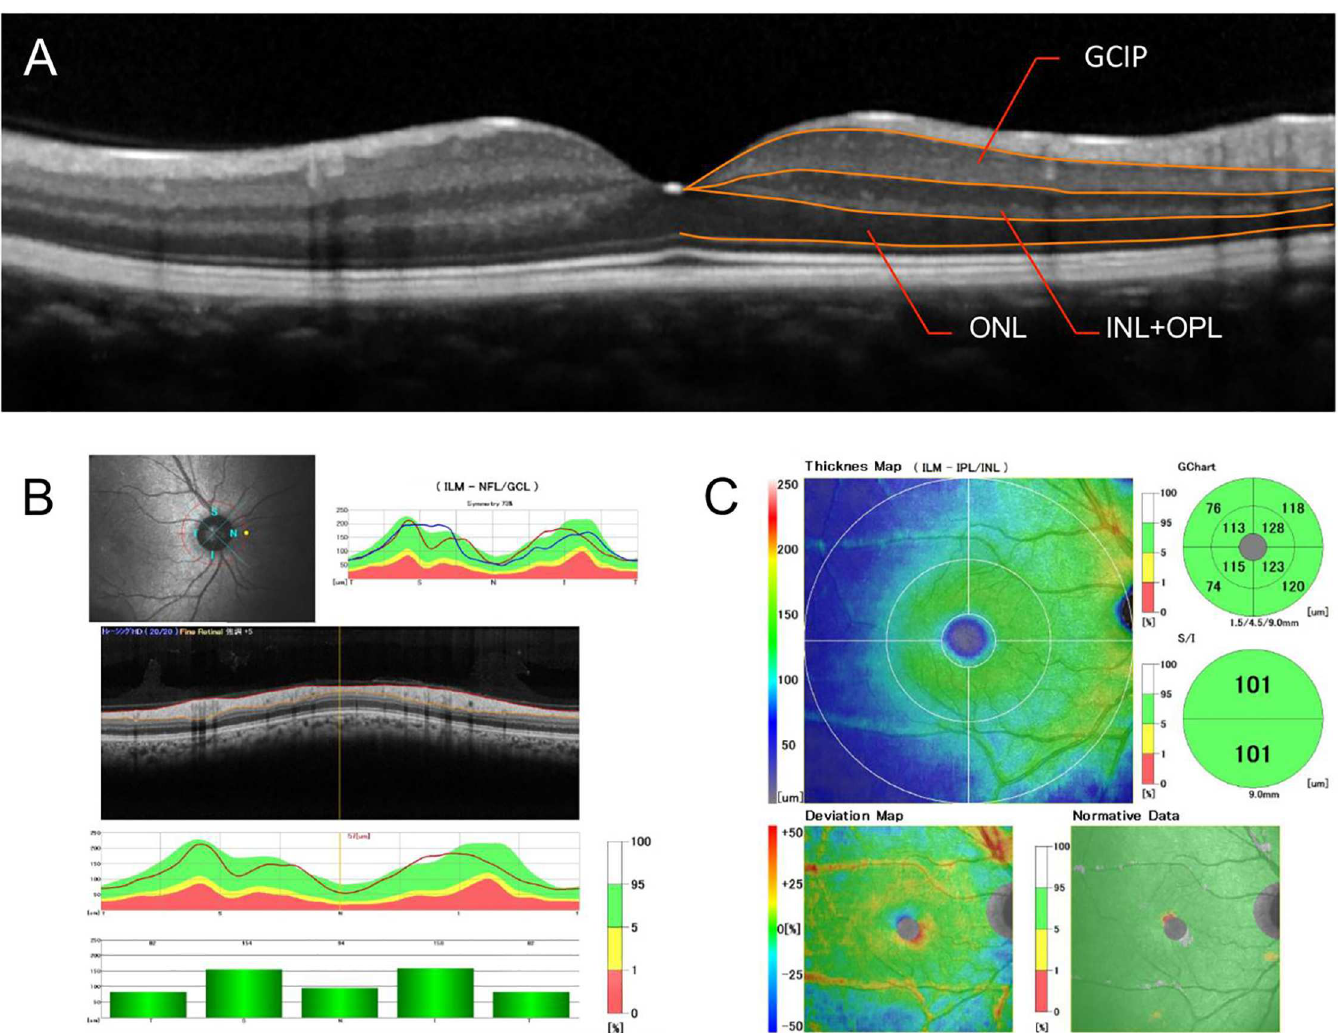
Fig 1. Representative optical coherence tomographic (OCT) images and retinal segmentation of the images. (A) Orange segmentation lines define the ganglioncell layer and inner plexiform layer (GCIP), the inner nuclear layer and outer plexiform layer (INL+OPL), and the outer nuclear layer (ONL). (B) Disc circle mode of OCT was used to evaluate the peripapillary retinal nerve fiber layer thickness aroundthe optic disc. (C) Macula map mode was used to evaluatethe thickness of the different retinal layers includingthe GCIP, INL+OPL, and ONL within a 9 mm x 9 mm area centeredon the